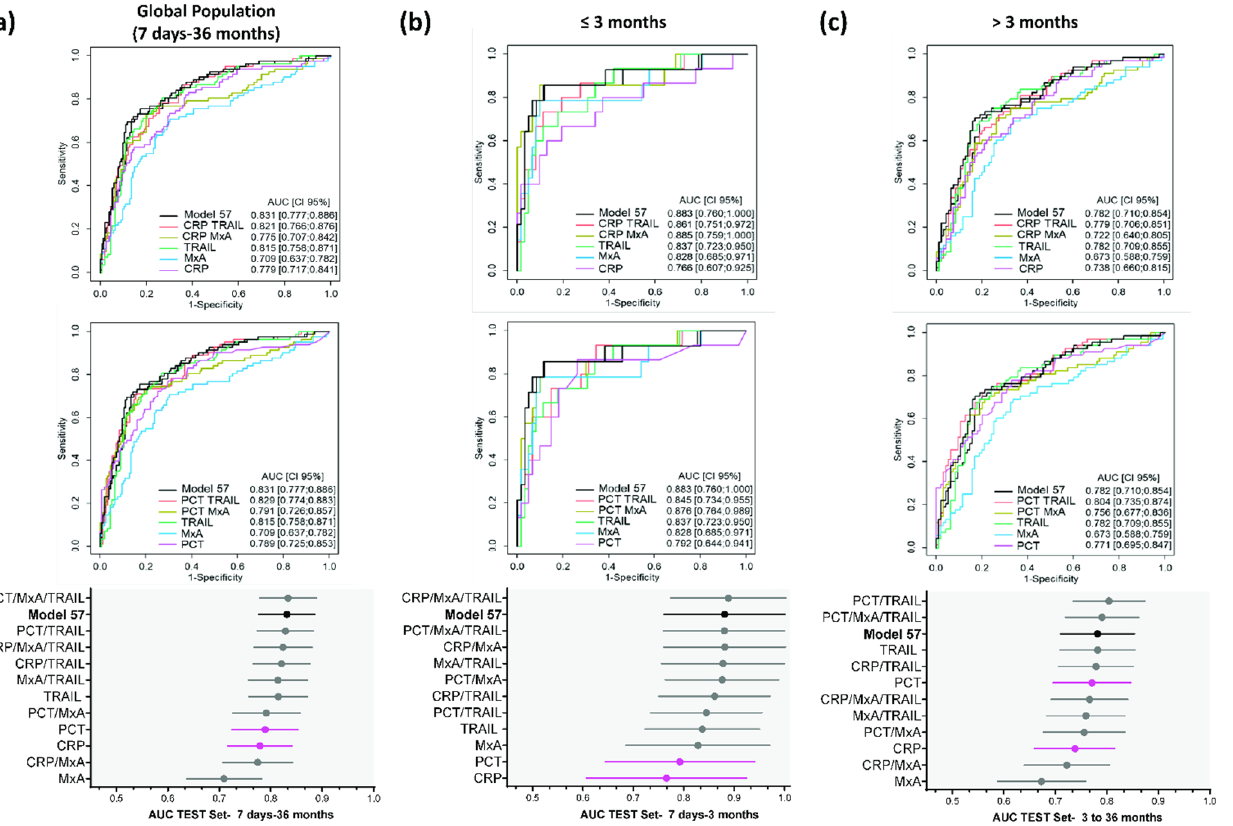
Figure 2. Performance of marker combinations using logistic regression (TEST set). ROC curves and forest plots of best performing models are shown for the global population ( a ), the ≤ 3-month-old patients ( b ), and the > 3-month-old patients ( c ). The upper ROC curves show the comparisons to CRP (pink curves) and the lower ROC curves the comparisons to PCT (pink curves). The forest plots depict AUC (plain circles) and respective 95% CI (horizontal whiskers). Model 57 (NGAL/MxA/TRAIL; black curves, black whiskers) performs best in terms of LR+ in the global population. Complete performance results of the depicted models are shown in Table S6. Performance results of all 98 models are shown in Table S5. The AUC of model 57 (0.831) was not statistically different from that of PCT (0.789; p = 0.115) but was significantly better than that of CRP (0.779; p = 0.042). The 4-marker model PCT/NGAL/MxA/TRAIL (model 67) achieved the highest AUC (0.839;